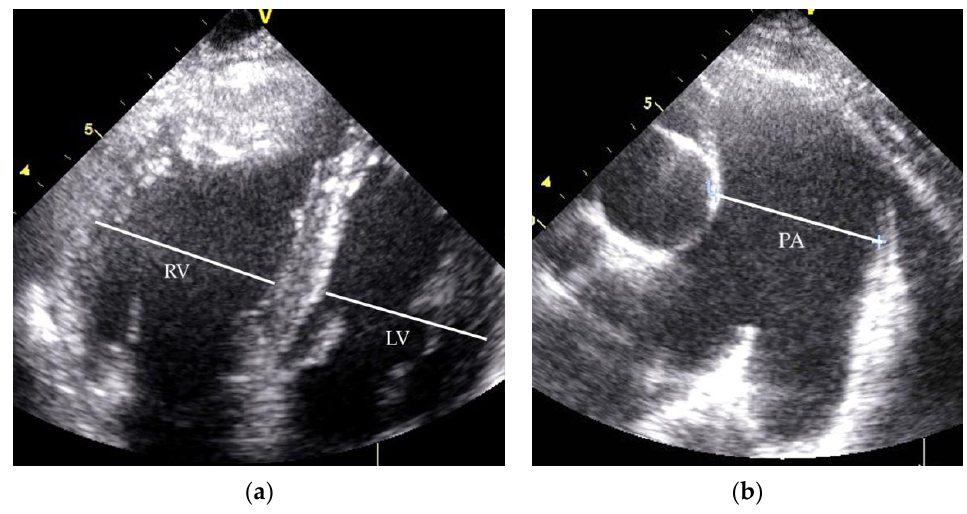
Figure 5. Patient 2 echocardiogram: ( a ) dilated right ventricle; ( b ) dilated pulmonary artery. RV—right ventricle; LV—left ventricle; PA—pulmonary artery. Table 3. Right heart catheterization hemodynamic parameters (Patient 2).